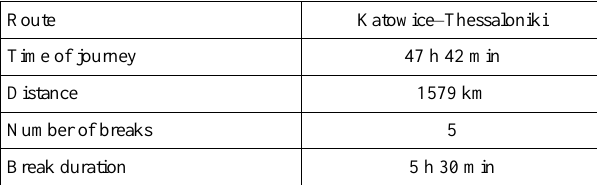
Table 8. Route details generated for Nissan Leaf